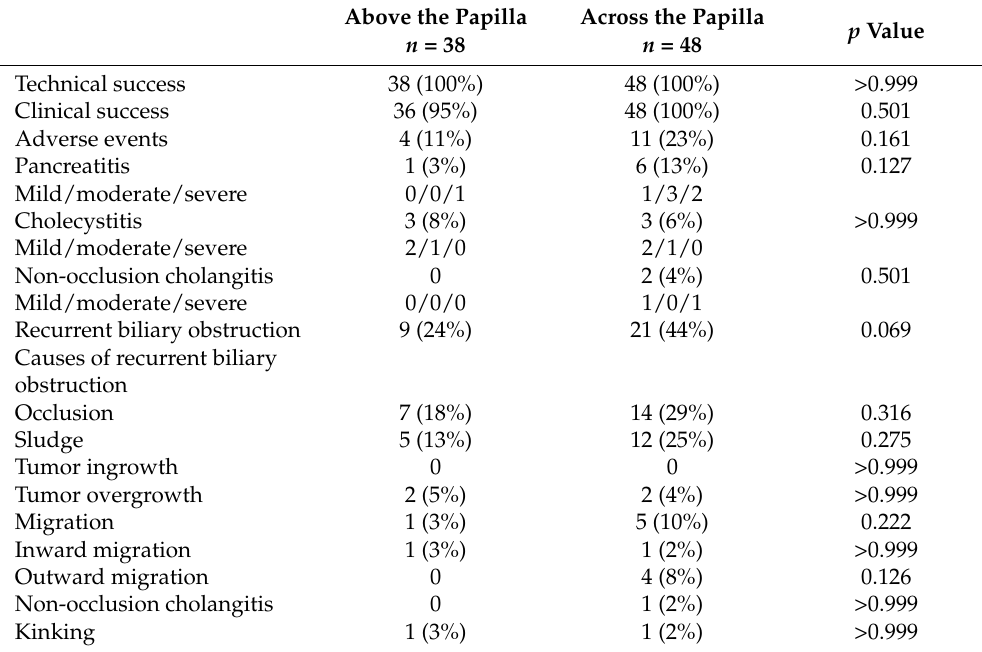
Table 2. Outcomes of covered metal stents placed above and across the